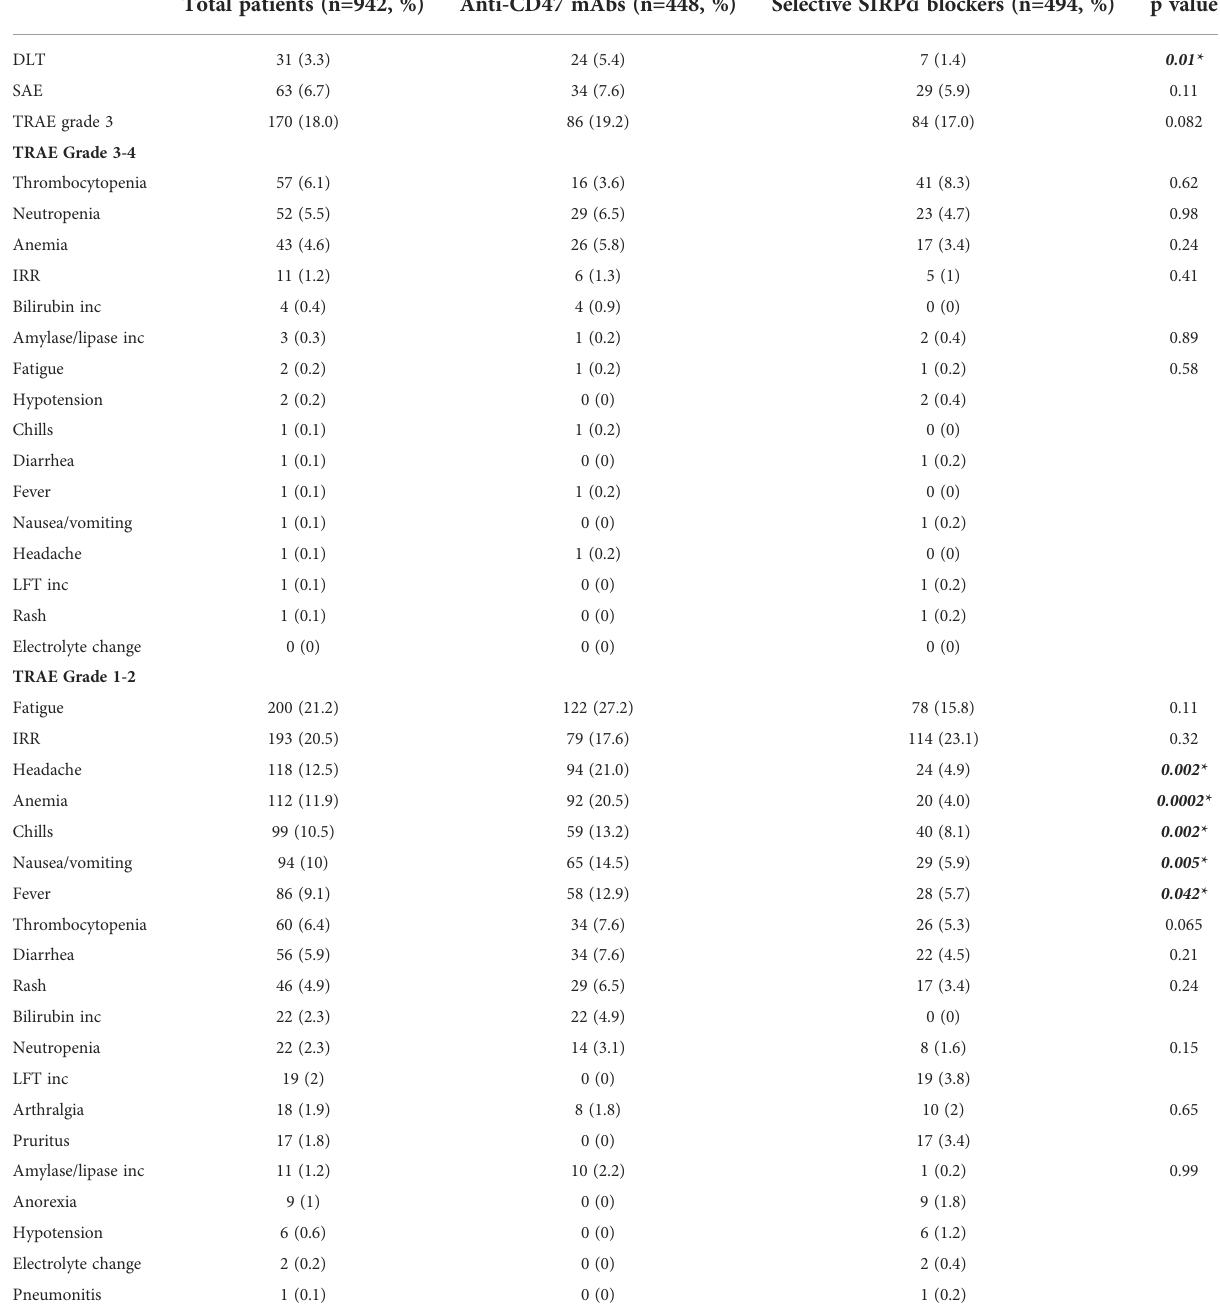
TABLE 4 Pooled patient-level toxicity data of CD47-SIRP a inhibitors in clinical trials. Total patients (n=942, %) Anti-CD47 mAbs (n=448,